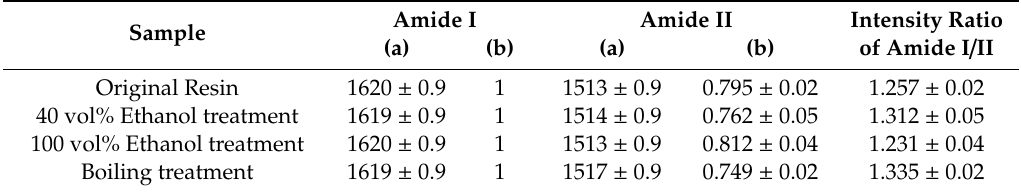
Table 4. Attenuated Total Reflectance Fourier-transform infrared (ATR-FTIR) assignment of the original RS resin and RS resin after di ff erent treatment conditions before the hot-rolling process.